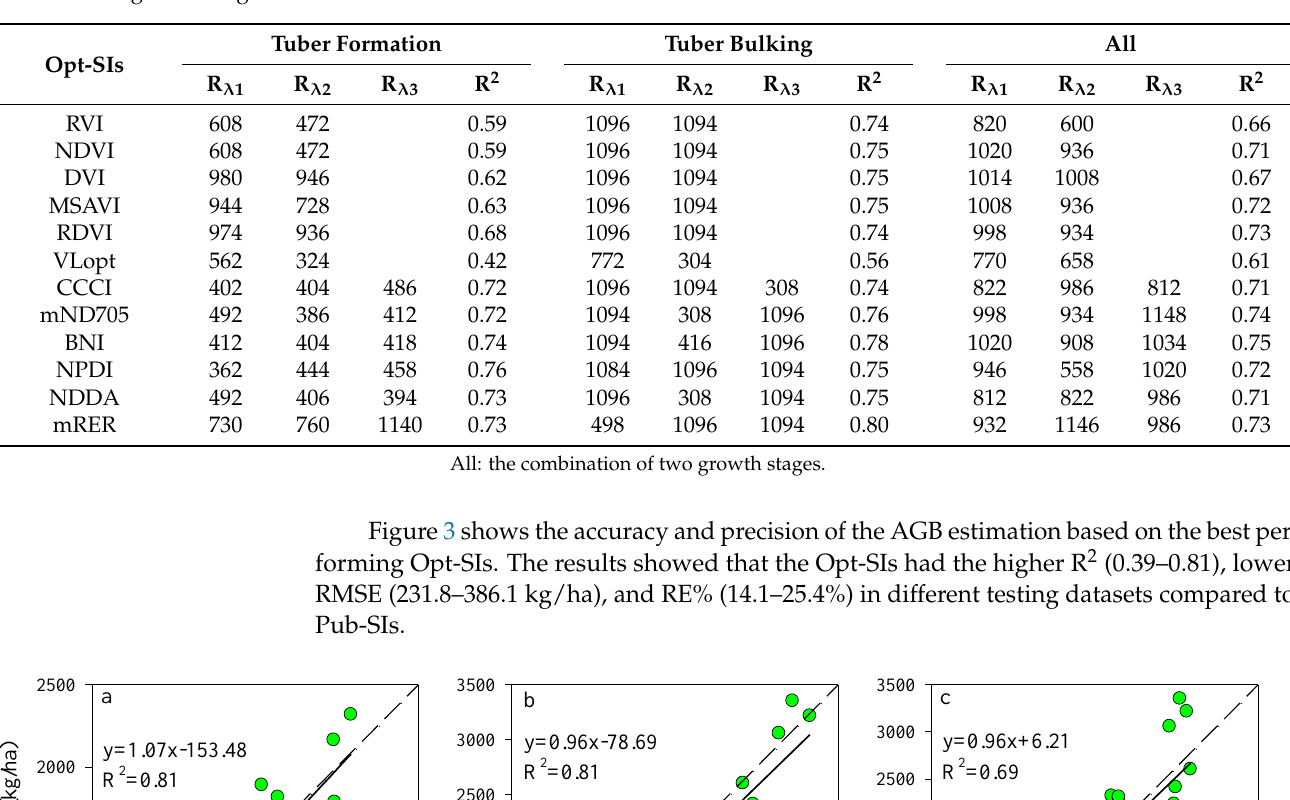
(350–450 nm), blue (450–500 nm), and near-infrared (NIR, 800–1100 nm) at all three datasets. Table 3. The band (nm) combination of Opt-SIs and corresponding relationships between Opt-SIs and potato AGB at different growth stages. Tuber formation Tuber bulking All Tuber Formation Tuber Bulking All Opt-SIs Opt-SIs R λ 1